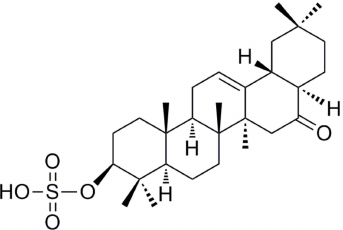
Figure 1. The chemical structure of auriculatone